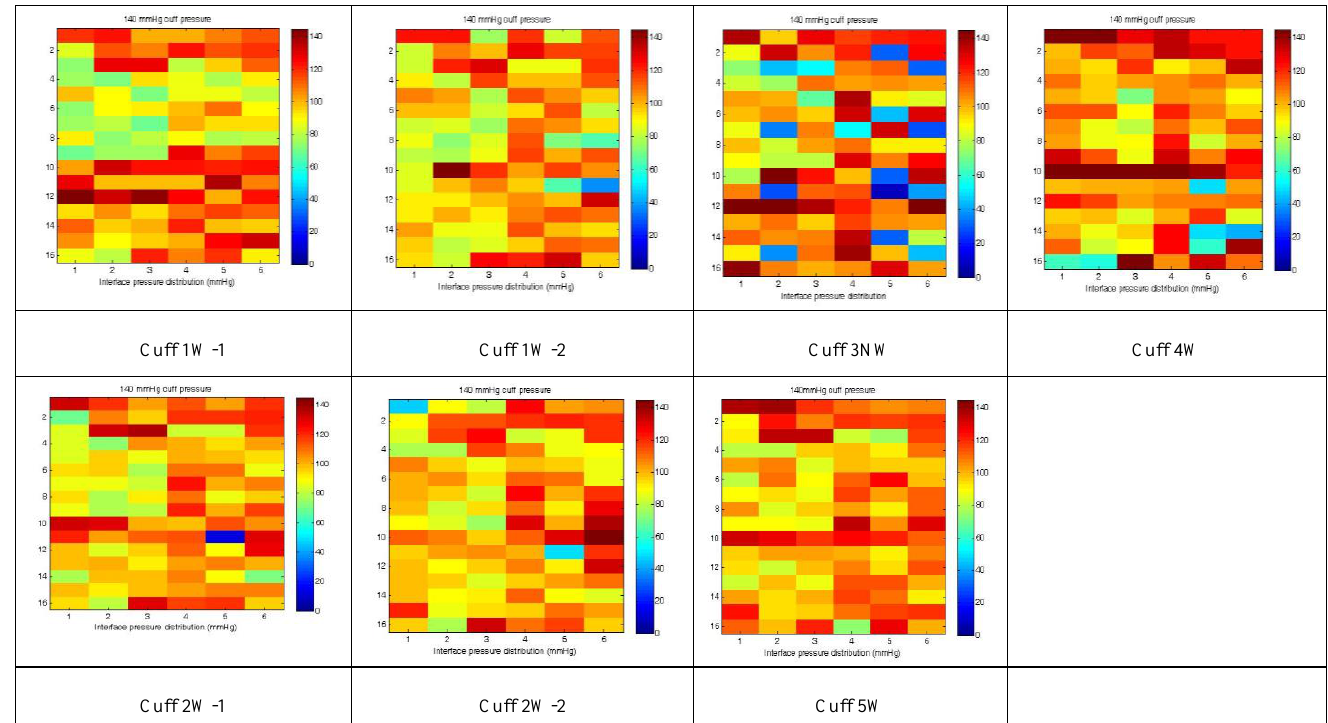
Fig. 4(a) Pressure distribution at cuff – metal cylinder interface at 120 mmHg inside cuff pressure